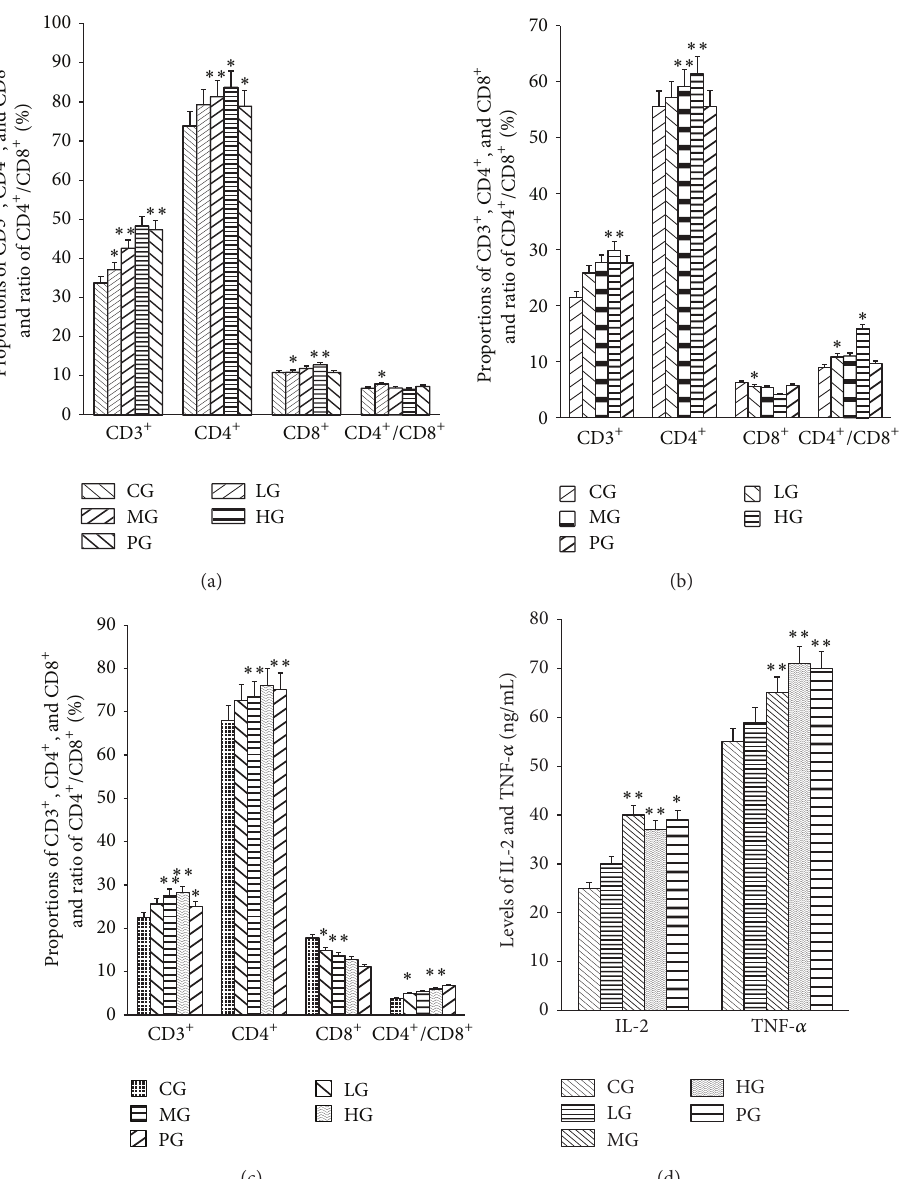
Figure 2: Effects of PFVM on T lymphocyte subpopulation in peripheral blood (a), thymus (b), spleen (c), and levels of IL-2 and TNF- 𝛼 in the serum of mice (d). CG, control group; LG, low dose group; MG, medium dose group; HG, high dose group; PG, positive control group. ∗ 𝑃 < 0.05 , ∗∗ 𝑃 < 0.01 versus control group.